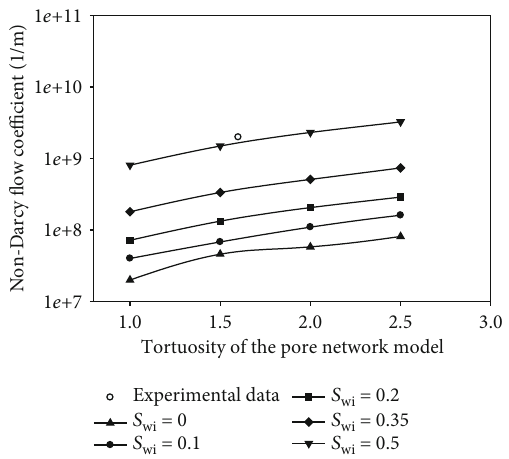
Figure 8: Curves of non-Darcy coe ffi cient and tortuosity at di ff erent irreducible water